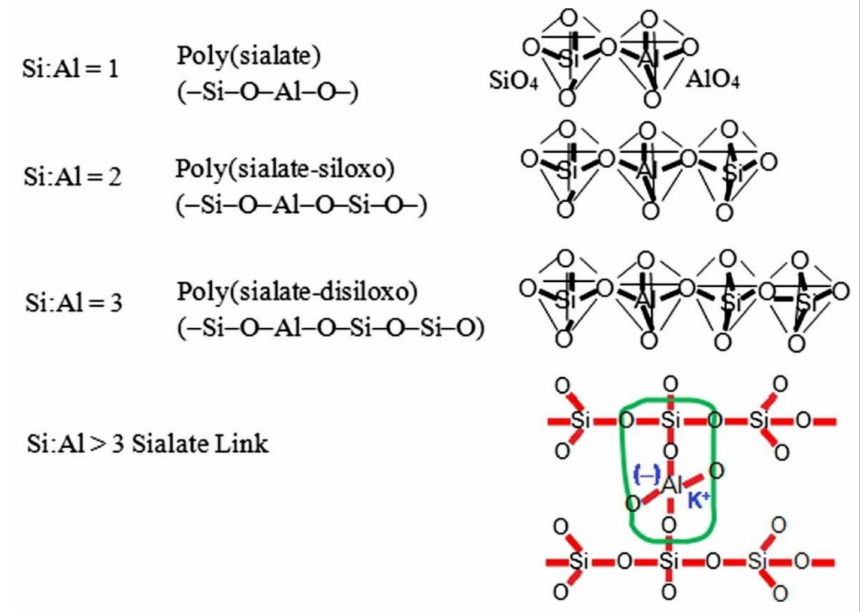
Figure 4. Siloxo Si-O units based on different geopolymeric systems. Reprinted with permission from Ref. [24]. Copyright 2016, with permission from